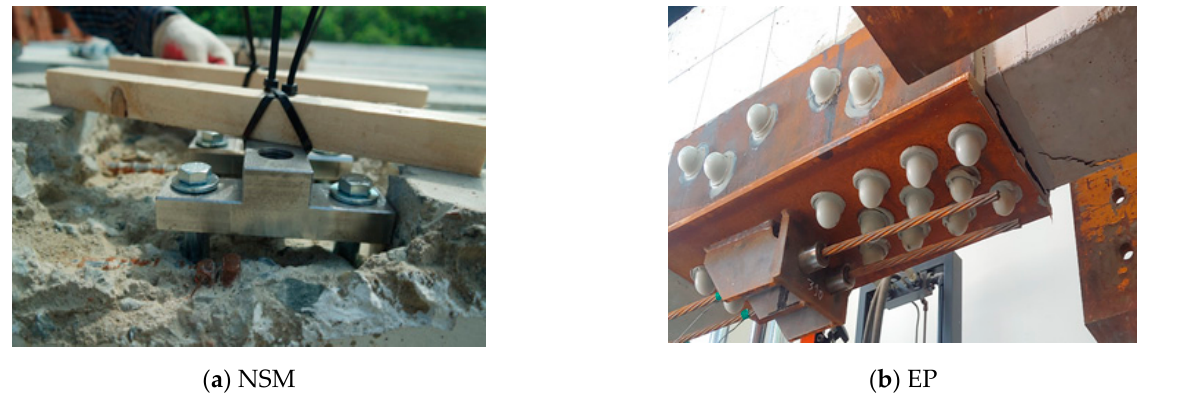
Figure 10. Problems associated with strengthening methods: ( a ) NSM and ( b ) EP.